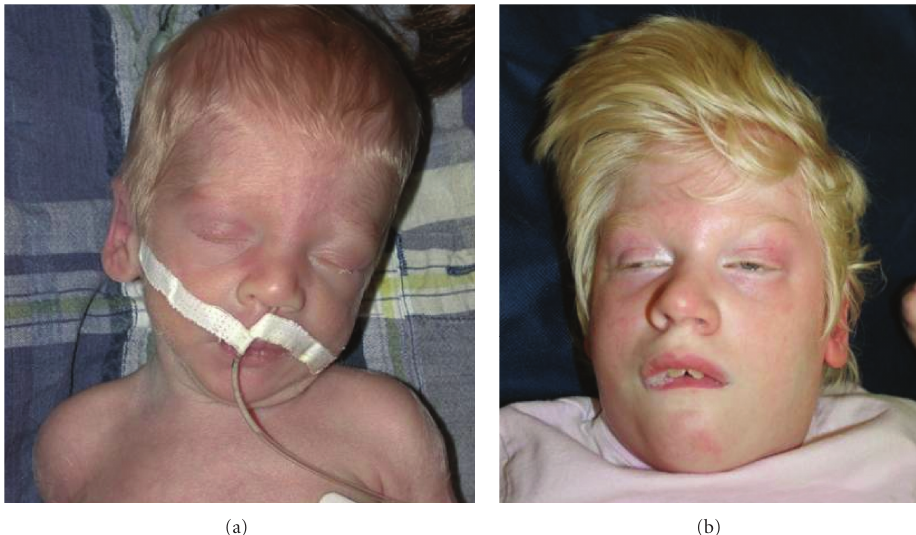
Figure 1: (a) Patient 1 and his sibling, (b) Patient 2, at 2 weeks and 6 years, respectively. Both patients have hypopigmentation and profound intellectual